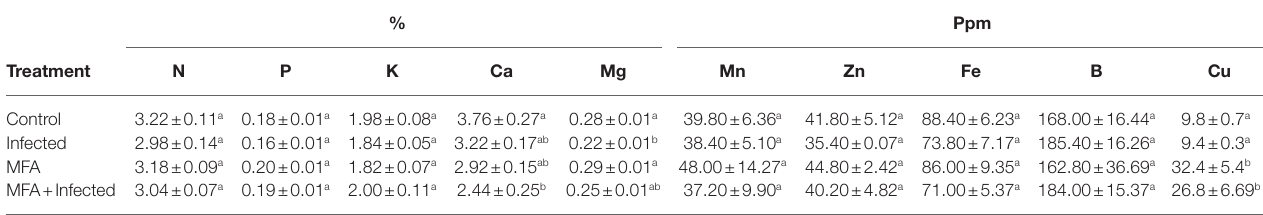
TABLE 2 | Leaf tissue nutrient analysis from Citrus sinensis after long-term MFA treatment.